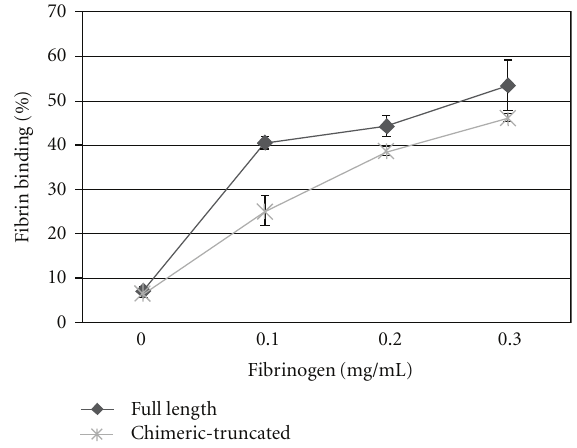
Figure 7: Binding to fibrin clots. Di ff erent concentrations of fibrin were incubated with full length ( (cid:2) ) or chimeric-truncated t-PA ( ∗ ) Data represent means obtained from three